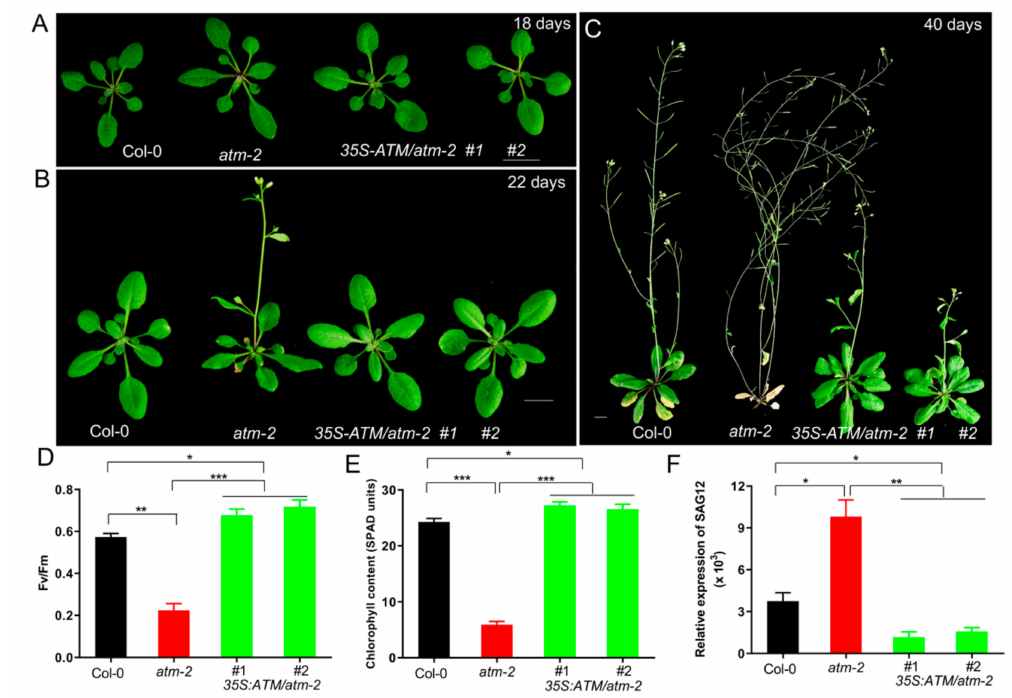
Figure 1. Overexpression of ATM (ataxia telangiectasia mutated) suppresses the early senescence phenotypes of atm mutant. ( A ) Rosette leaves of 18-day-old plants of Col-0, atm-2 and 35S-ATM / atm-2 . ( B ) Overexpression of ATM suppresses the early flowering phenotype of atm-2 mutant under long-day conditions (18 L / 6 D). ( C ) Senescence phenotypes of 40-day-old plants of Col-0, atm-2 and 35S-ATM / atm-2 . ( D – F ) Photochemical e ffi ciency of PSII (Fv / Fm) ( D ), chlorophyll contents ( E ), and qRT-PCR analysis of SAG12 expression ( F ) in the third and fourth leaves of 35-day-old plants of Col-0, atm-2 and 35S-ATM / atm-2 . Three biological replicates were performed. Error bars represent standard deviation (SD, n = 24 for D and E ; n = 3 for F ). Student’s t test, * p < 0.05, ** p < 0.01 and *** p <